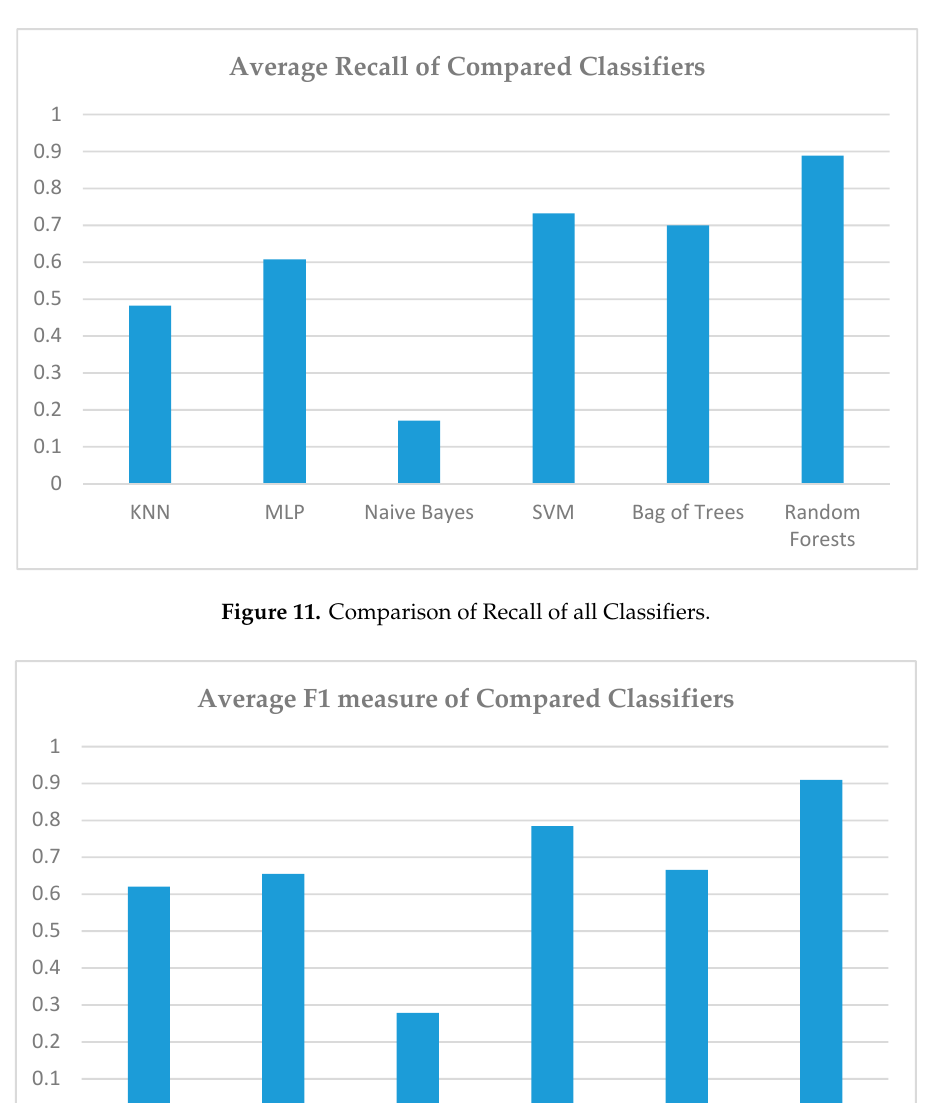
Figure 10. Comparison of Accuracy of all Classifiers.